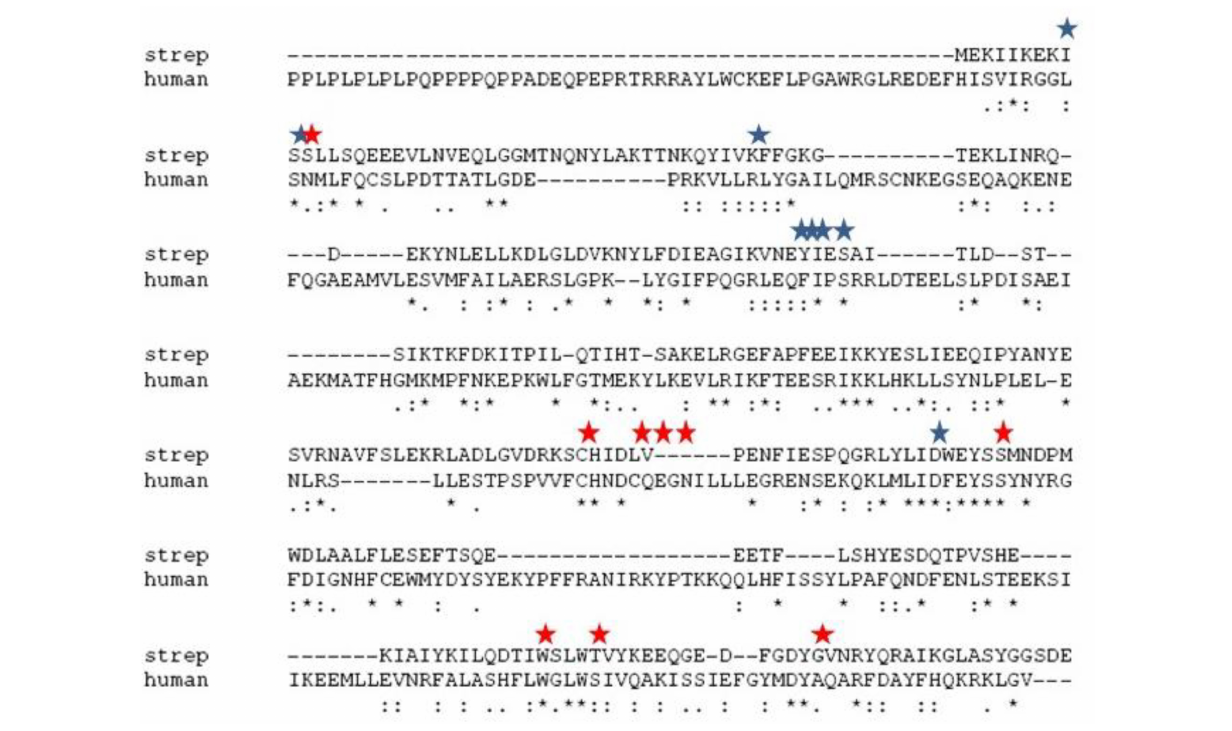
FIGURE 1 | Alignment of the primary sequences of sChok and hChoK using ClustalW. The positions of the choline kinase binding residues of hChoK are shown in with a red star. The ATP binding site residues are shown with a blue